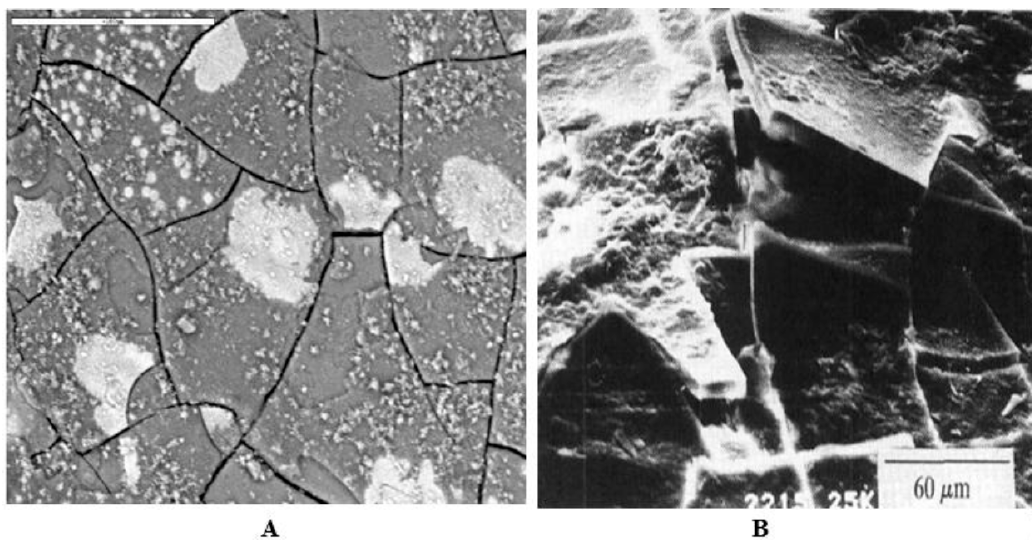
Figure A1. SEM images of glass surface: ( A ) sample K26 from underground repository; ( B ) sample BS8 from open testing area.